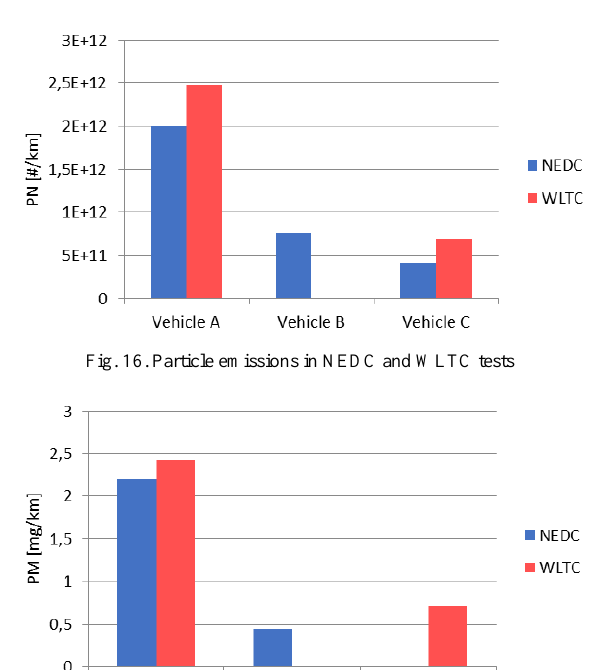
Fig. 15. Nitrogen oxides emissions in NEDC and WLTC tests